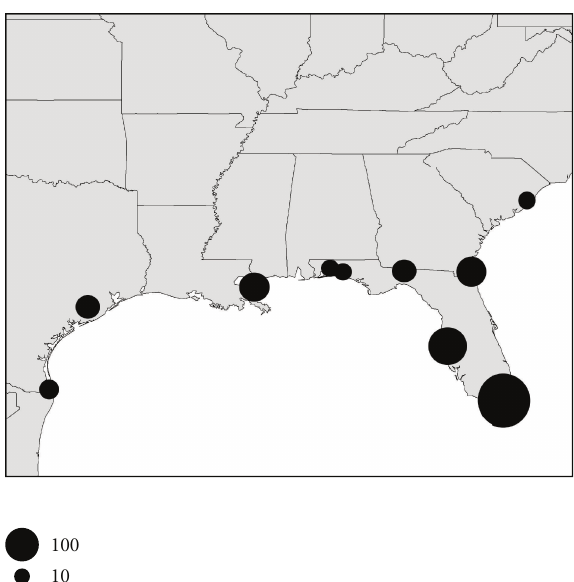
Figure 1: Predicted distribution of adult monarch butterflies in the southern United States in winter, based on a CLIMEX model that calculates suitable conditions for adult survival from environmental data (redrawn with permission from [12]). Size of black circles refers to an index score of abundance given by the CLIMEX model (not number of